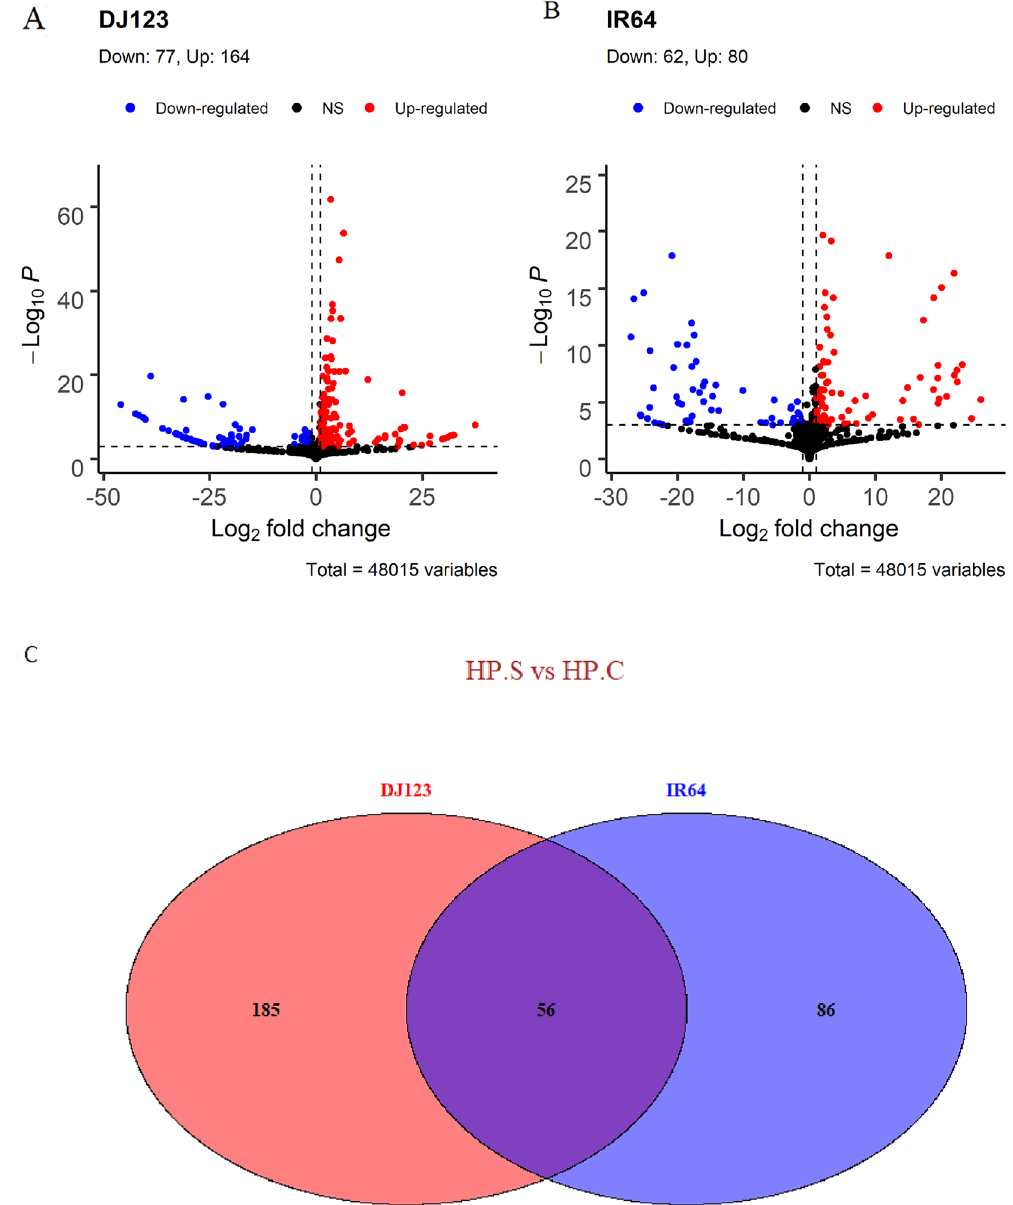
Figure 6. Volcano plots showing significantly up- or down-regulated genes in different tissues between DJ123 and IR64. The logarithm of fold change (log2) of each transcript is presented on x-axis, and the log10 of the P value are on y-axis. Thresholds are ‘pCutoff = 10e−16’ and ‘log2FoldChange > 1’. Venn diagram of the differentially expressed transcripts (DETs) in roots of DJ123 and IR64. The numbers of the DETs represent the DETs in HPS treatment against HPC treatment (HPS vs